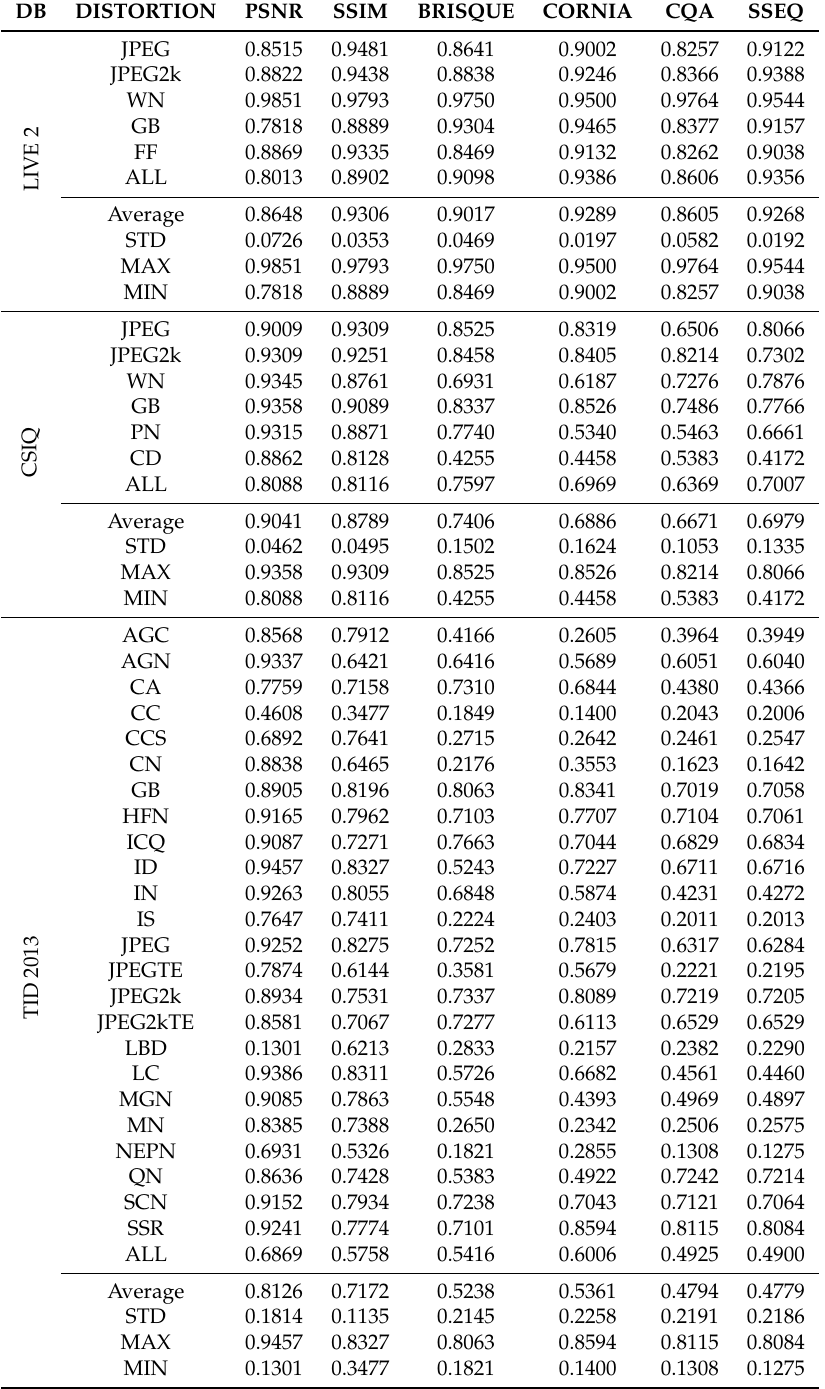
Table 7. Average SROCC of 100 runs of simulations on tested image databases using state-of-the-art IQA